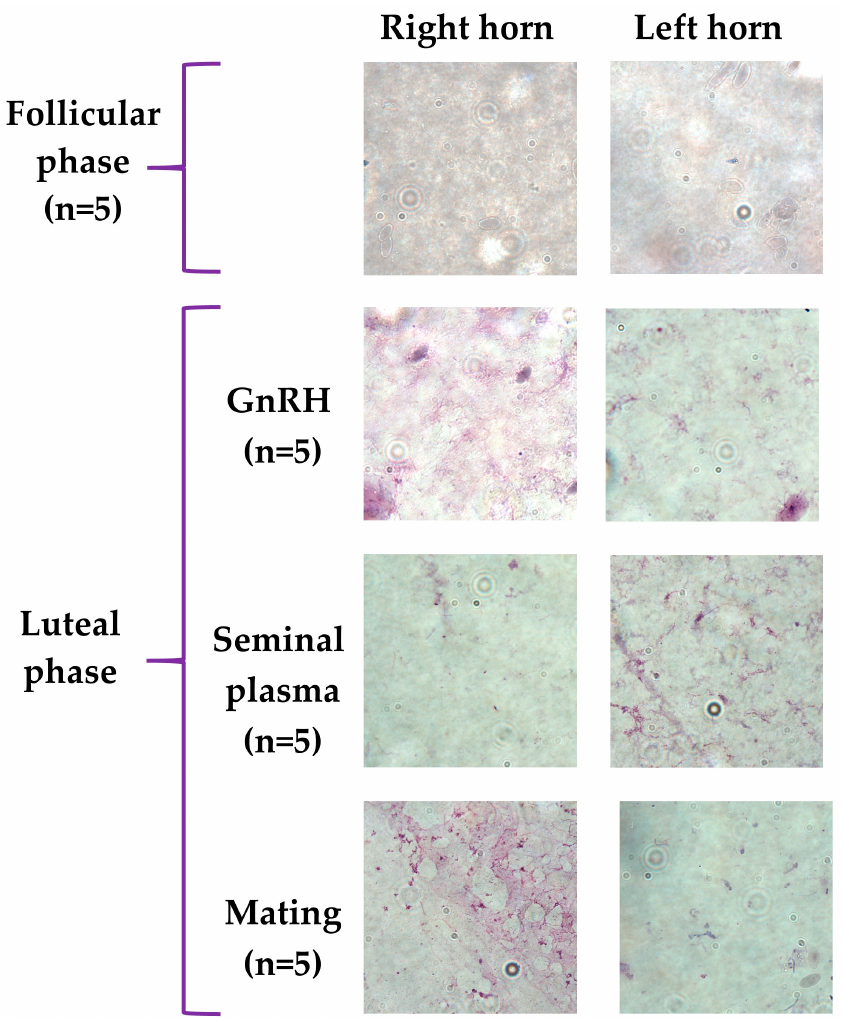
Figure 1. Absence of inflammatory cells in uterine fluid of llamas in follicular and luteal phase. A 50 µ L aliquot of fresh uterine fluid from uterine horns. Right and left smears were performed for cellular characterization. Hemacolor ® microscopy kit (Merck, Germany) was used for cell staining. The images were produced with the Olympus BX51 microscope (Olympus, Japan). The smears were observed in magnification 100X and with 10 fields per